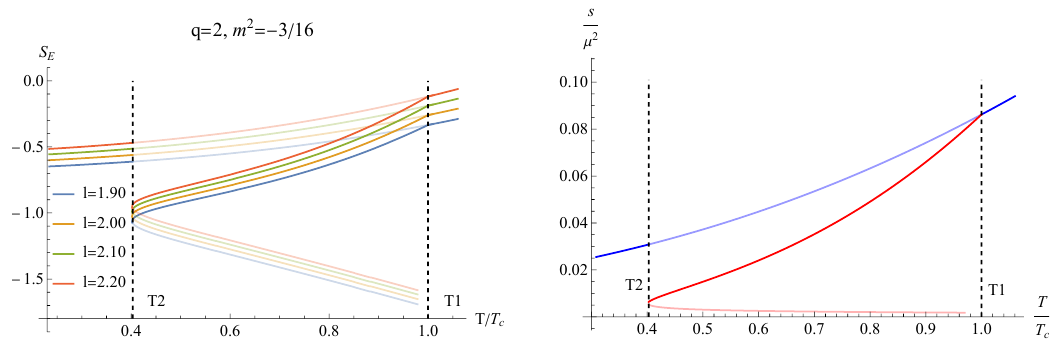
Figure 8 . HEE S E and entropy density s versus temperature when the zeroth-order phase tran- sition occurs at T 2 = 0 . 4029 . Left plot: HEE S E versus temperature T/T c with different l . The T c transparent lines represent metastable states and the solid lines represent stable states. The entropy density s versus temperature. The solid lines indicate the stable state and the lighter lines indicate the metastable state. The blue line corresponds to the normal state, while the red lines depict the superconducting states. The zeroth-order phase transition occurs in T 2 = 0 . 4029 and the second T c order phase transition occurs in T 1 = 1 . T c